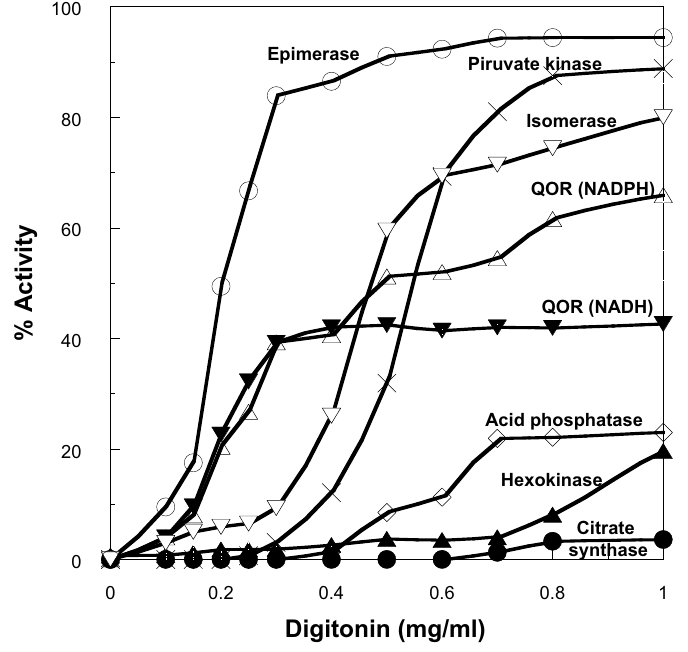
Fig. 7 – Behaviour of ribulose 5-phosphate epimerase activity upon digi- tonin extraction of T. cruzi epimastigotes. The experiment was perfomed as described by Maugeri and Cazzulo